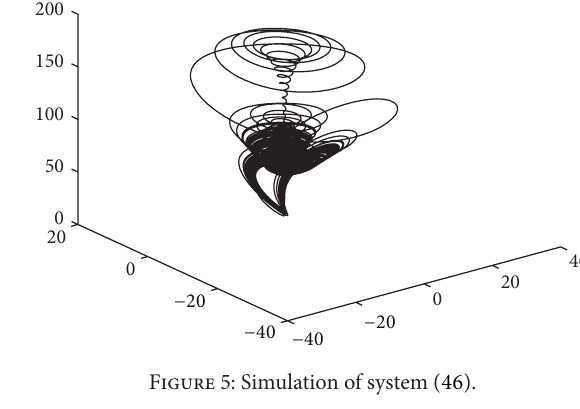
Figure 3: Simulation of system (44).